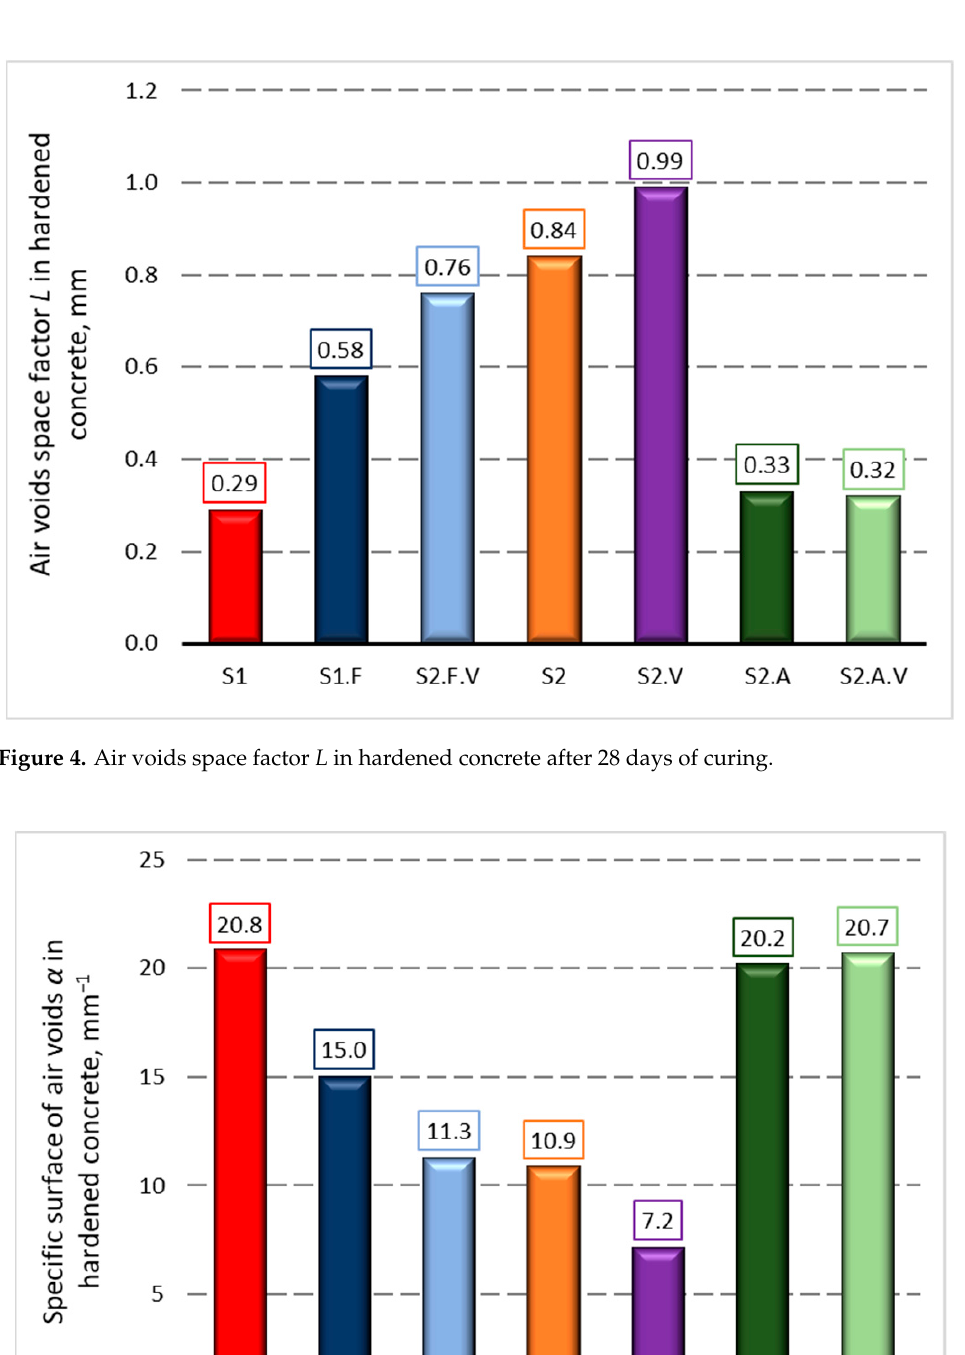
Figure 3. Results of measurements of the total volume of air voids, A , and the volume of voids, A300 , with a diameter less than 300 μ m in hardened concrete after 28 days of curing.